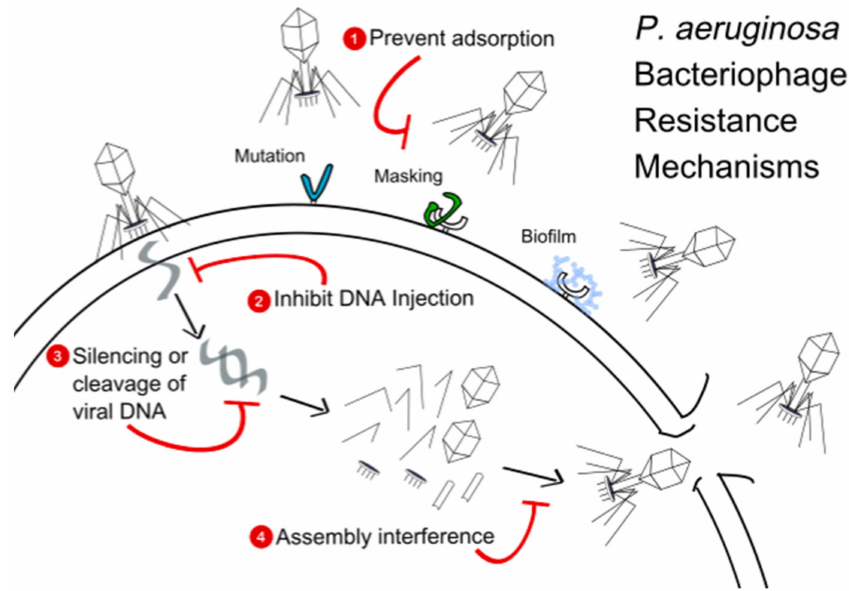
Figure 2. Representation of multiple P. aeruginosa phage resistance